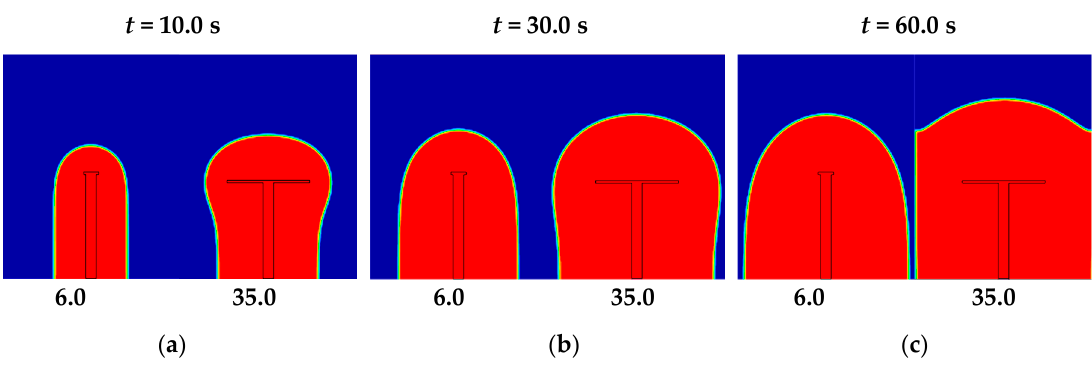
Figure 10. Resin volume fraction for ϕ = 0.05, H / L = 1.0, H 0 / H 1 = 40.0, L 0 / H 0 = 0.1 and two different ratios of L 1 / H 1 = 6.0 and ( L 1 / H 1 ) o = 35.0 as a function of time: ( a ) t = 10.0 s, ( b ) t = 30.0 s, ( c ) t = 60.0 s.